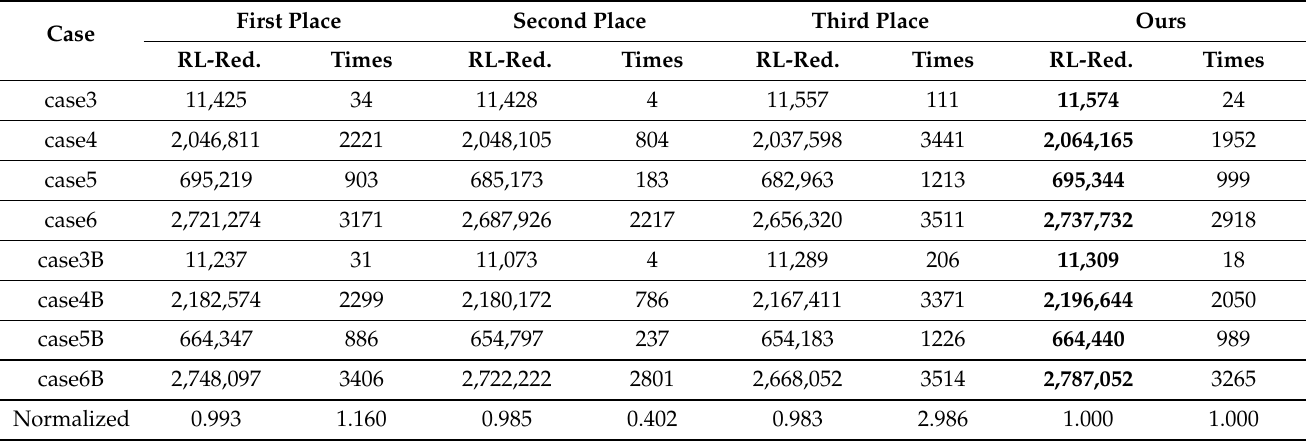
Table 3. Comparison of the total length reduction and runtime between our algorithm and top three